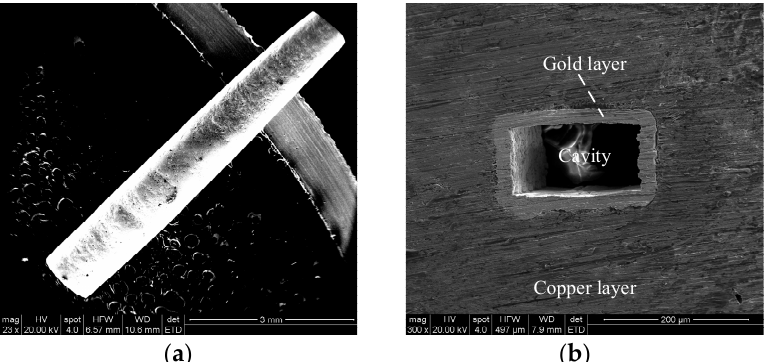
Figure 10. SEM examples of terahertz waveguide cavity with pure-aluminum sacrificial mandrel dissolved: ( a ) integral topography, ( b ) end-face topography.